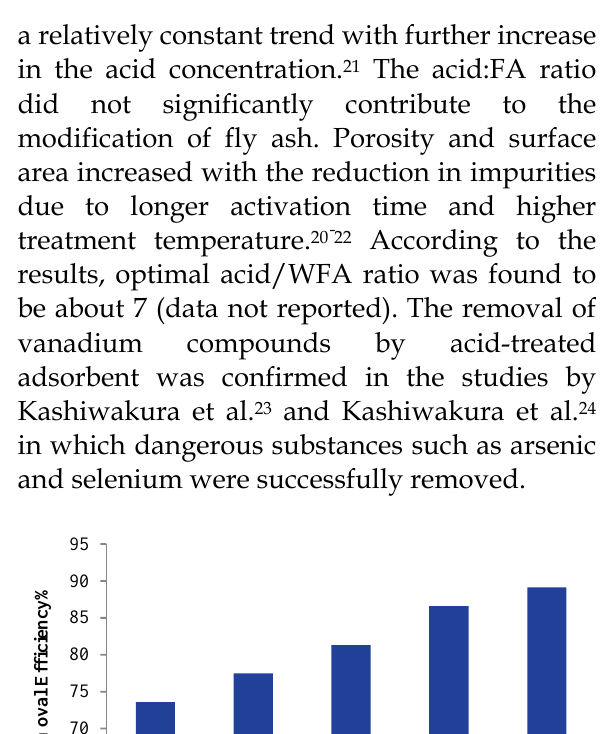
Figure 4. Effect of activation temperature on removal efficiency [cyanide: 30 mg/l, unadjusted pH] Figure 5 shows changes in removal efficiency with MFA to nanoparticles ratio for different contact times. The cyanide removal efficiency for MFA, TiO 2 /UV, and MFA- TiO 2 /UV were found to be 76.1, 81, and 86.6%, respectively. Accordingly, the removal